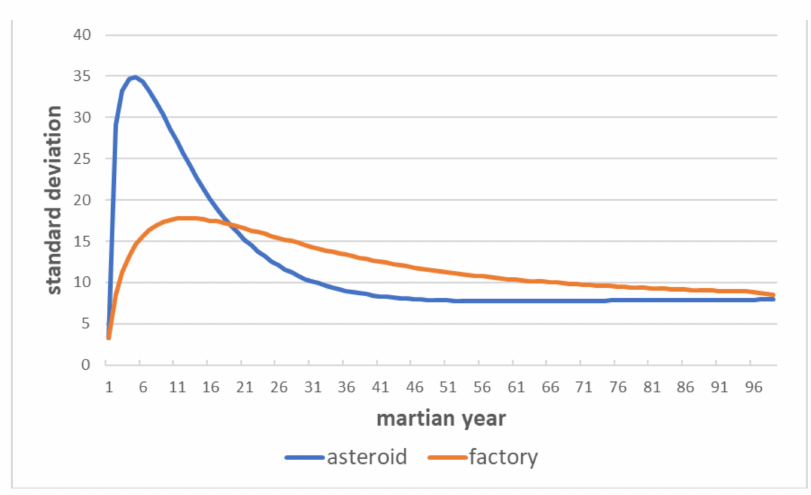
Figure 17. Standard deviation of the temperature rise on Mars over 100 simulation years after the initial event.